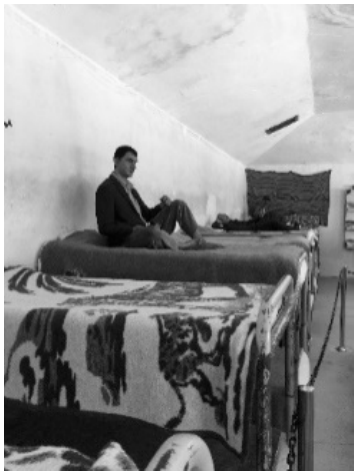
Figure 12. Inmates bunk beds with mannequins at the Ulucanlar Museum.